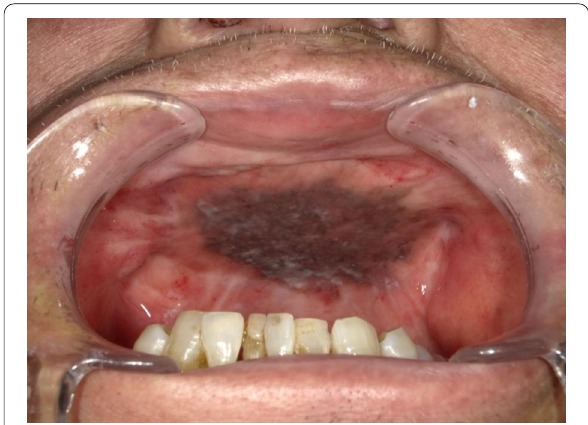
Fig. 8 Intraoral photograph showing the reconstructed palate with the loss of the alveolar